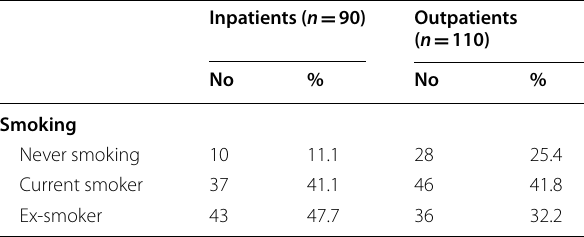
Table 2 COPD patients as regards the dyspnea grading